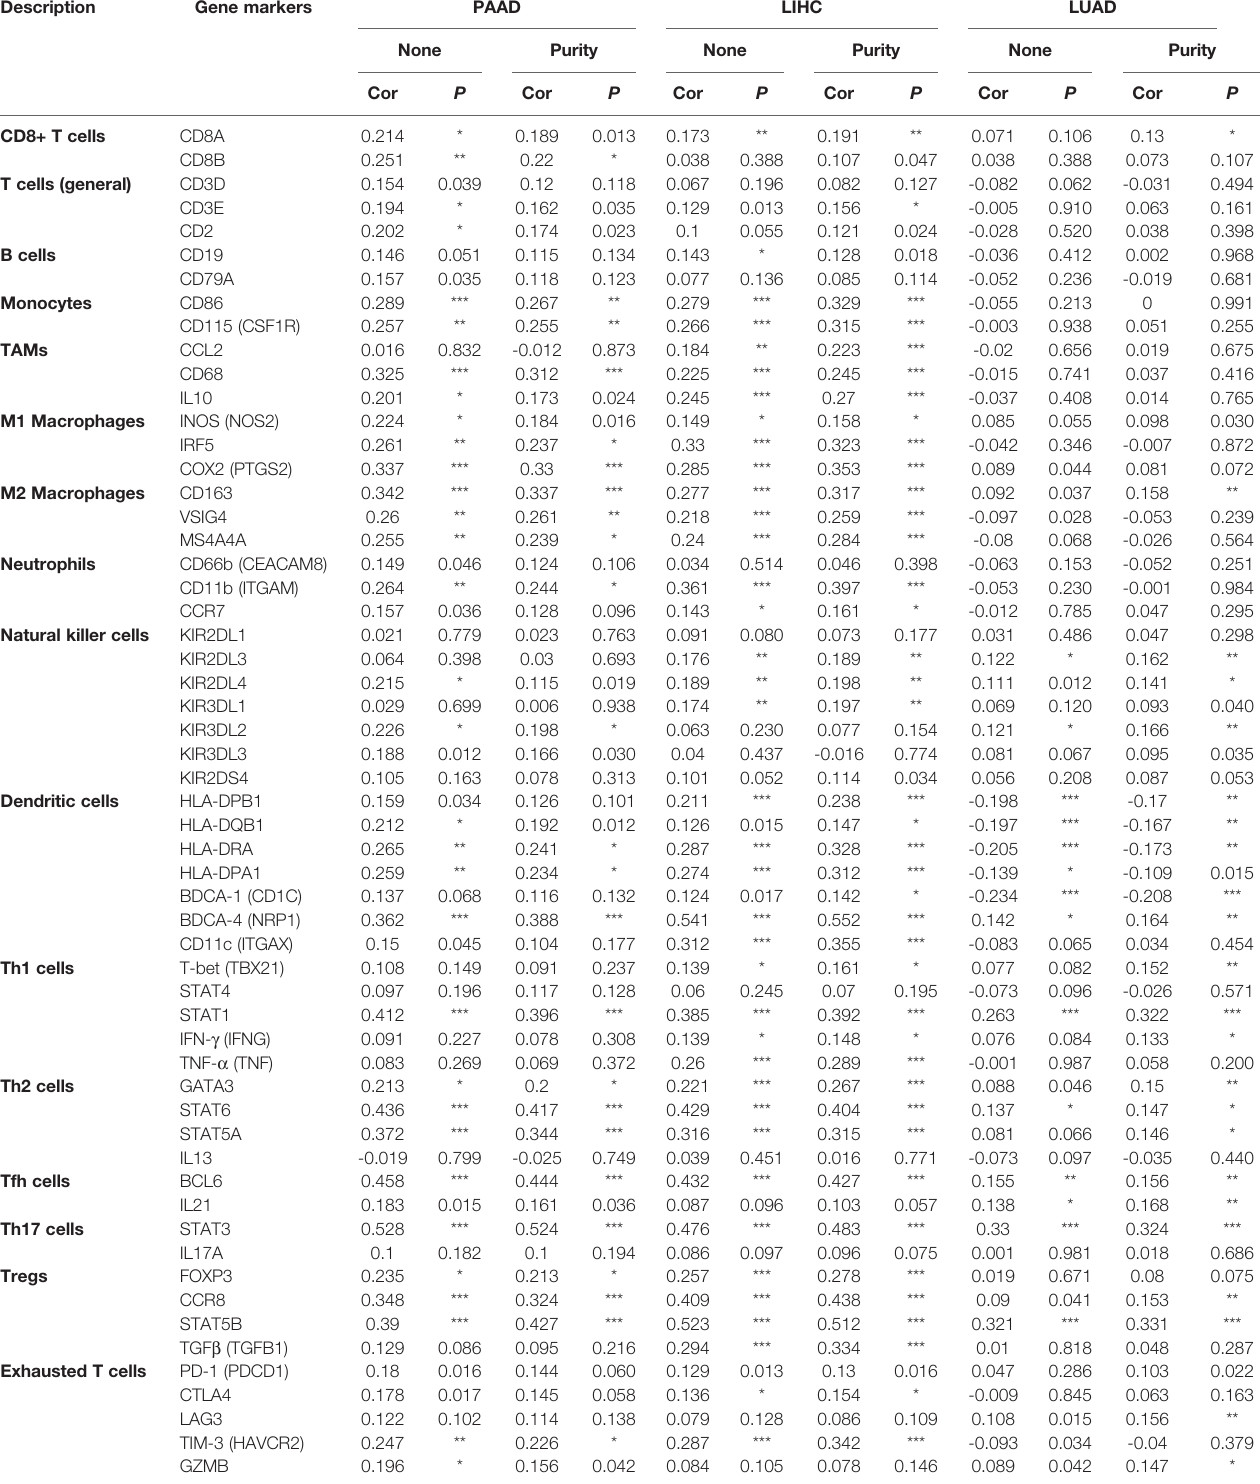
TABLE 1 | Analysis of correlations between USP10 expression and immune cell markers by TIMER.